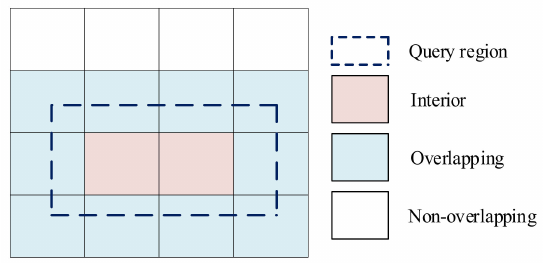
Figure 3. Interior grids and overlapping grids in a query